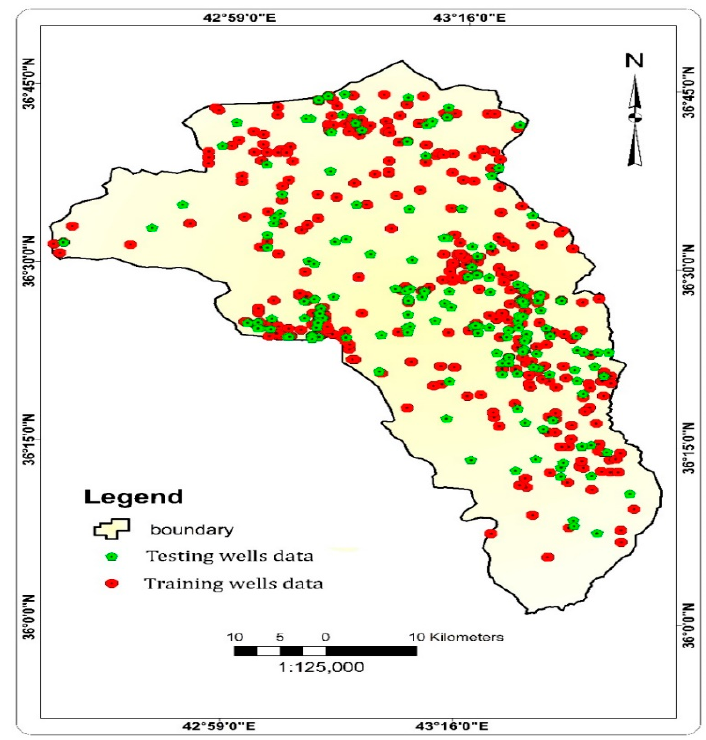
Figure 9. Groundwater wells inventory map.